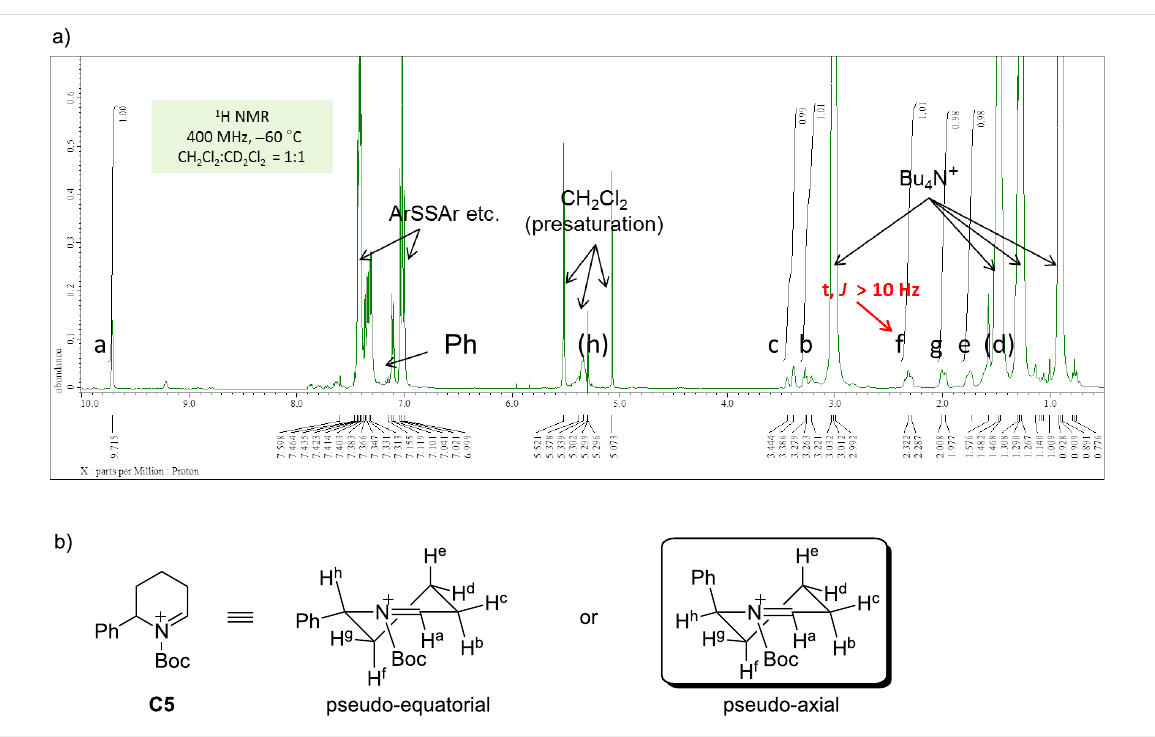
Figure 3: (a) 1 H NMR spectrum of C5 in CD 2 Cl 2 at − 60 °C (400 MHz). (b) Preferred conformation of C5